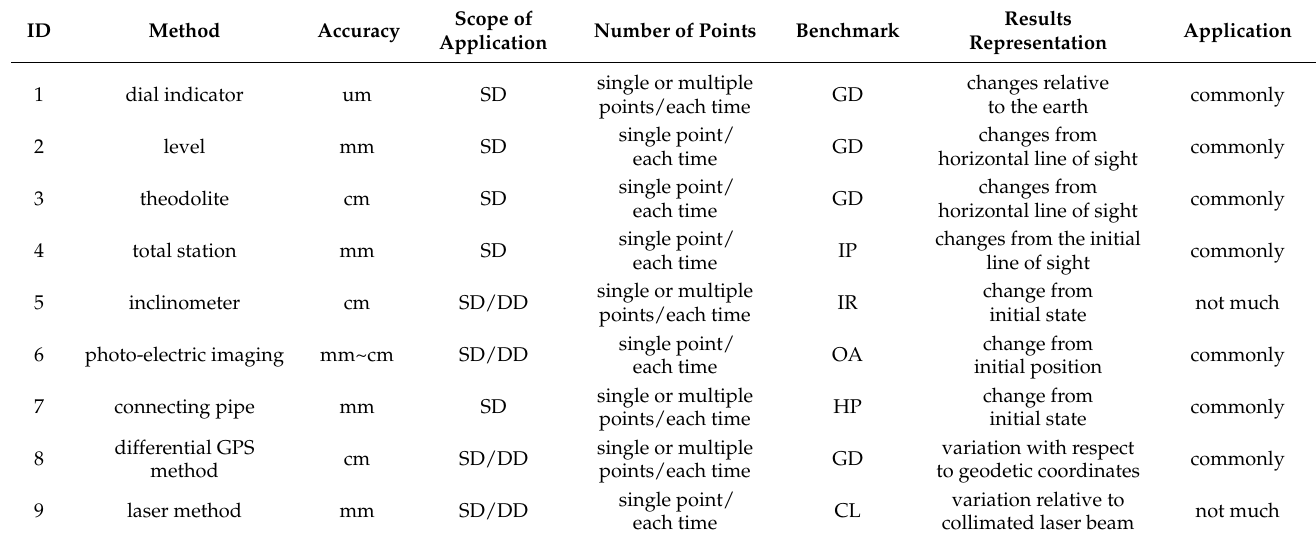
Table 1. Comparison of different displacement